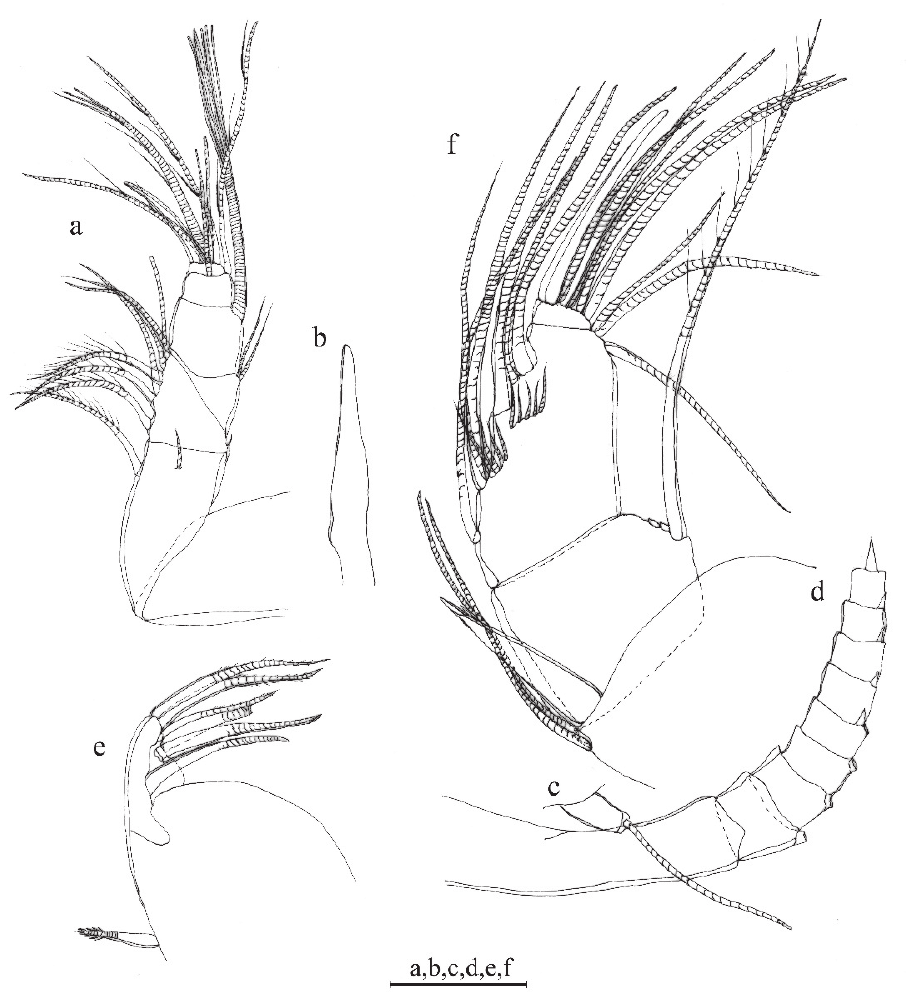
Figure 11. Parasterope sohi sp. nov. holotype female adult: a A1 b bellonci organe c A2 endopodite d A2 exopodite e Md basale endite f Md endopodite. Scale bar: 0.1